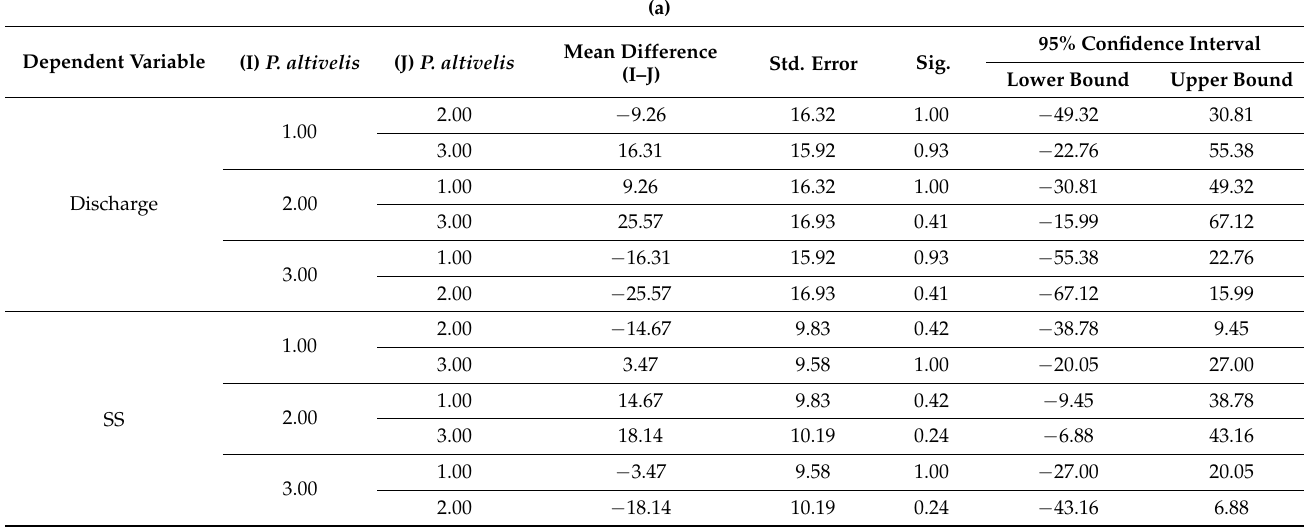
Table 4. The results of multiple comparisons (Bonferroni) between the number of caught P. altivelis (a) and T. hakonenis (b) and environmental factors (discharge, ss, and temperature) are shown. The underlined results are important values indicating that environmental factors did not significantly affect the survey